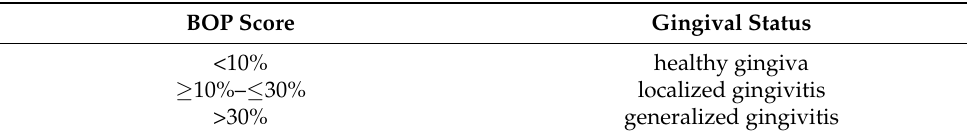
Table 1. BOP score describing the condition of the gingiva.